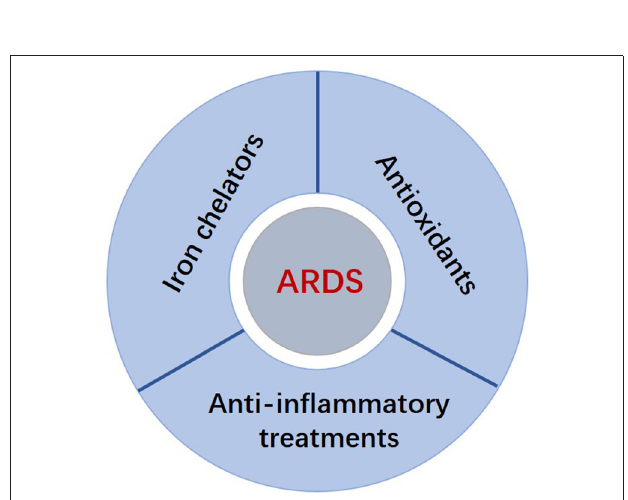
FIGURE 3 | Treatments for ARDS. Therapeutic targets for ARDS associated with ferroptosis, such as iron chelators, antioxidants and anti-inflammatory